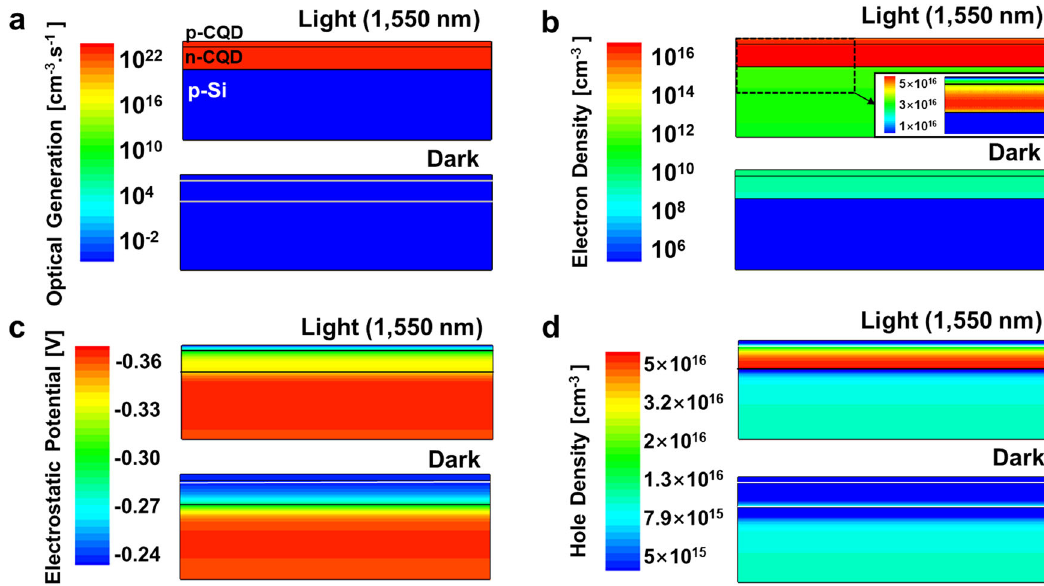
Fig. 2 Sentaurus TCAD simulations of the PVTRI. The device parameters are shown in Table S1. a Optical generation under illumination of 1550 nm compared with the equilibrium in dark. Photo-included carriers are generated in the p-CQD and n-CQD layers. b Electron density of the PVTRI. The majority of photoelectrons aggregate at the base region and at the interface of Si:n-CQD. c Electrostatic potential of the PVTRI. A higher negative electrostatic potential (photovoltage) is obtained under illumination of 1550 nm. d Hole density of the PVTRI. The negative photovoltage at the interface can attract holes transferring from silicon to the base region under the illumination of 1550 nm.